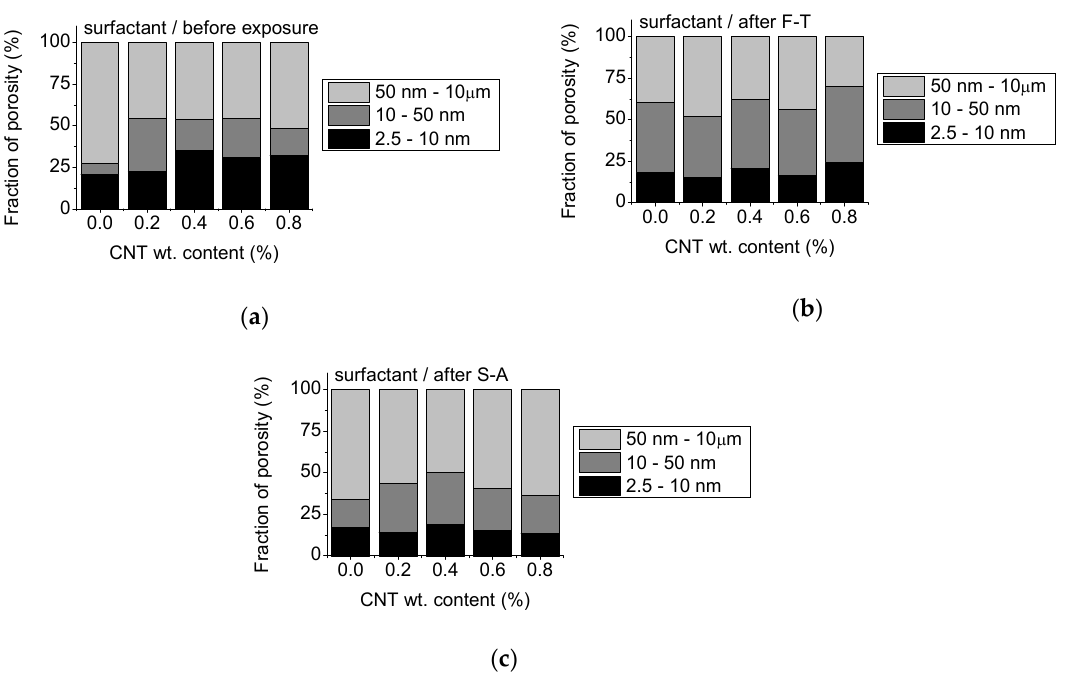
Figure 8. Fraction of gel (2.5–10 nm), medium capillary (10–50 nm) and large capillary (50 nm–10 µ m) pores of mortars prepared using superplasticizer as dispersant: ( a ) before exposure, ( b ) after F-T and ( c ) after S-A.